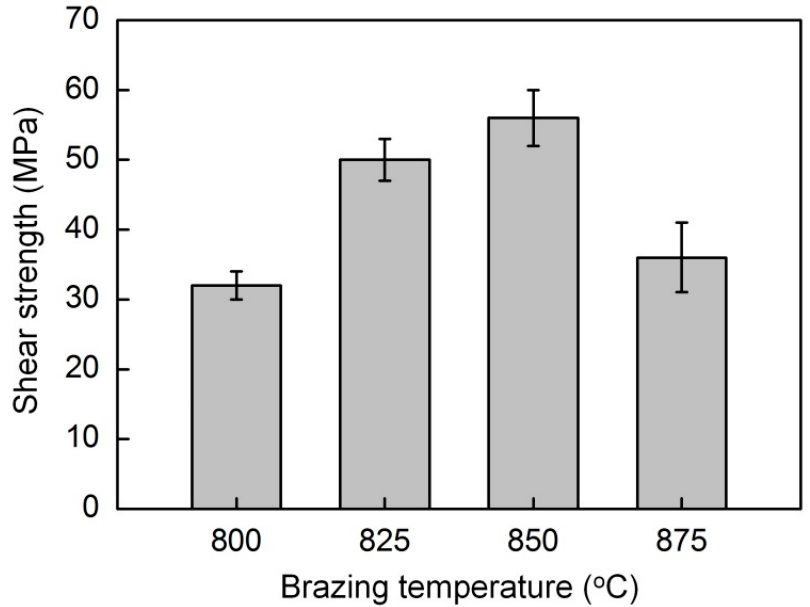
Figure 6. Shear strength of the ZTA/AgCu + ABOw/Ti6Al4V joints brazed at different temperatures. The fracture morphologies of the joints obtained at different temperatures are shown in Figure 7. The results indicated that the joints obtained in the temperature range of 800~875 ◦ C mainly fractured at and near the ZTA/(Cu,Al) 3 Ti 3 O interface. Furthermore, when the brazing temperatures were less than 825 ◦ C, some fractured whiskers coated with very fine Ag-based alloy and reaction products can be observed on the fracture surfaces.